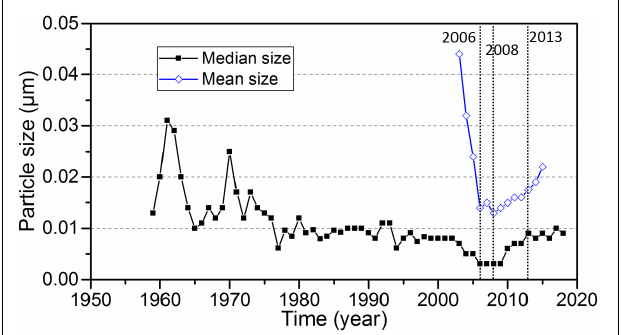
FIGURE 3 | Changes of the median and mean particle size of suspended sediment at Yichang